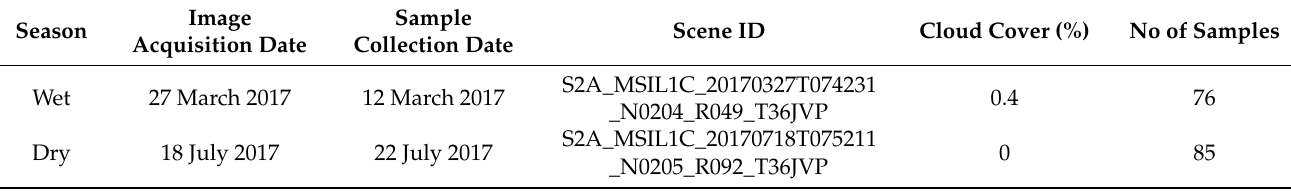
Table 1. Temporal sequencing, identity details, cloud cover percentages of Sentinel-2 images that were used and field samples by scene